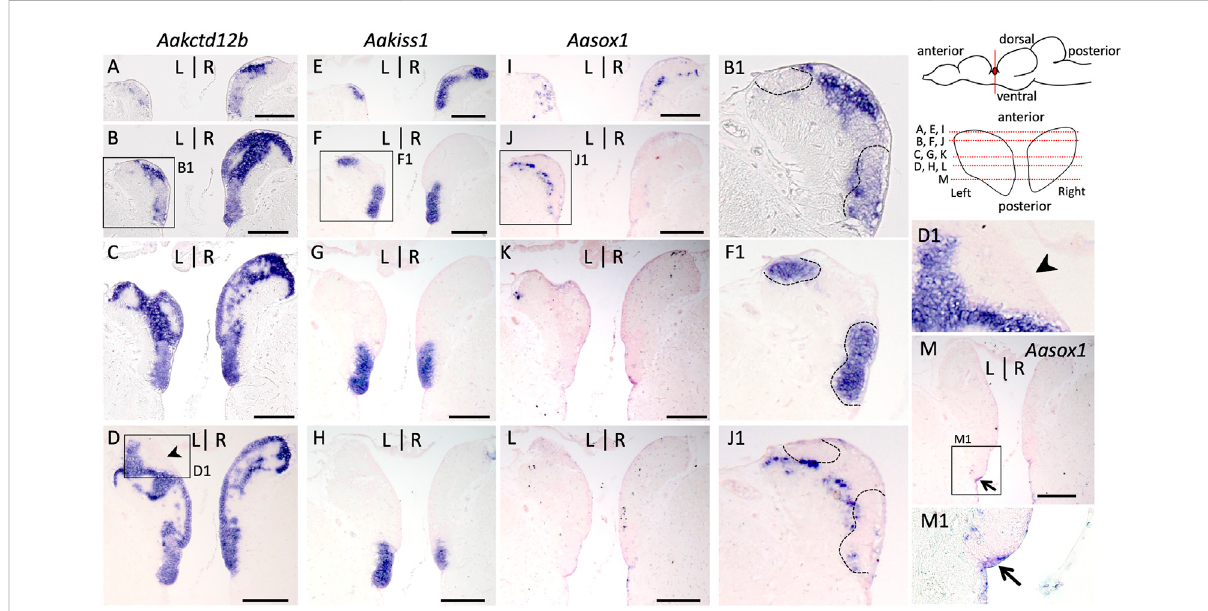
FIGURE 7 Subdomain organization of habenulae in the European eel. (A – M) transverse sections of habenulae in A. anguilla (silver specimens) following ISH with probes for Aakctd12b (A – D) , Aakiss1 (E – H) and Aasox1 (I – M) . The orientation of section planes is shown in a schematic lateral view of A. anguilla brain and section levels along the antero-posterior axis are shown as red dotted lines on a front view of habenulae schematized in the top right corner. (B1,F1,J1,D1,M1) are higher magni fi cation views of the areas boxed in (B,F,J,D,M) . Black arrowheads point towards the left dorsal nucleus positive for pax6, and negative for PCNA and Aakctd12b. The thin arrow in (M,M1) points towards Aasox1 positive neural progenitors. The dotted line in (F1) and adjacent sections (B1) and (J1) delimits the Aakiss1 positive territory, which is adjacent to, but largely excludes Aasox1 expression at anterior-most levels of the habenulae. At this level, Aakiss1 expands dorsally but it is restricted to the organ ventral parts at medial to posterior levels. Scale bars = 200 μ